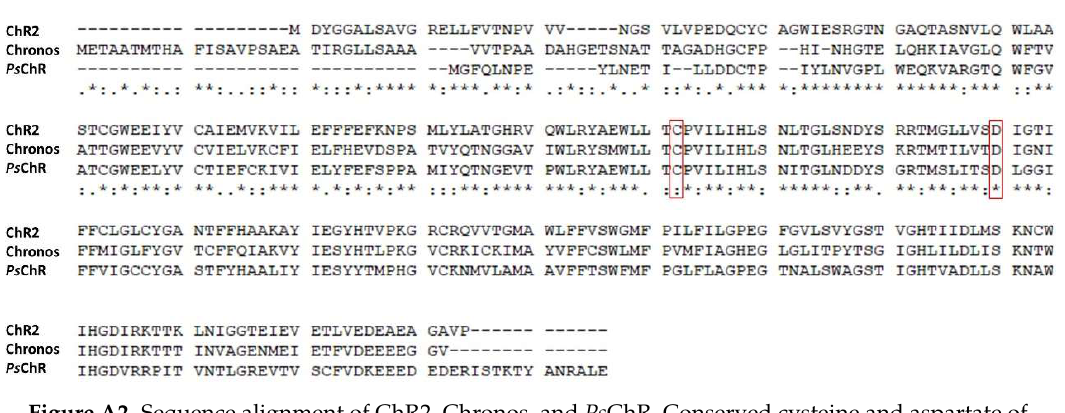
Figure A2. Sequence alignment of ChR2, Chronos, and Ps ChR. Conserved cysteine and aspartate of the DC gate were marked in the red